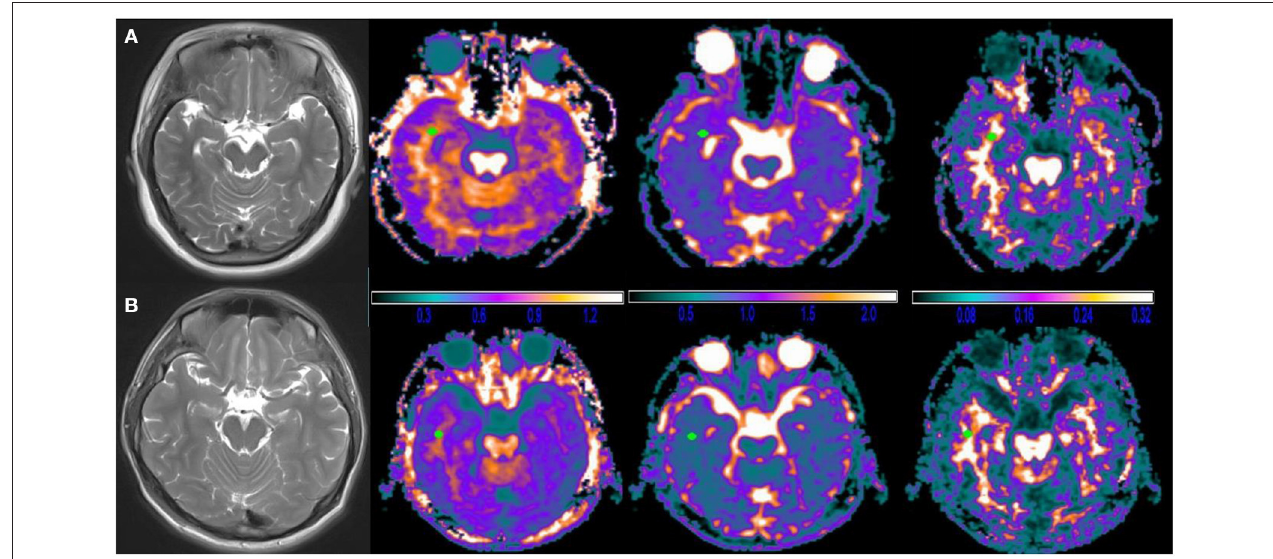
FIGURE 2 | Typical diffusional kurtosis imaging (DKI)-derived parametric maps in a case brain. (A) Female, 27 years old, R-TLE with sleep disorder, (B) Male, 35 years old, R-TLE without sleep disorder; from left to right are T2WI images, mean kurtosis (MK) maps, mean diffusivity (MD) maps and fractional anisotropy (FA) maps. No